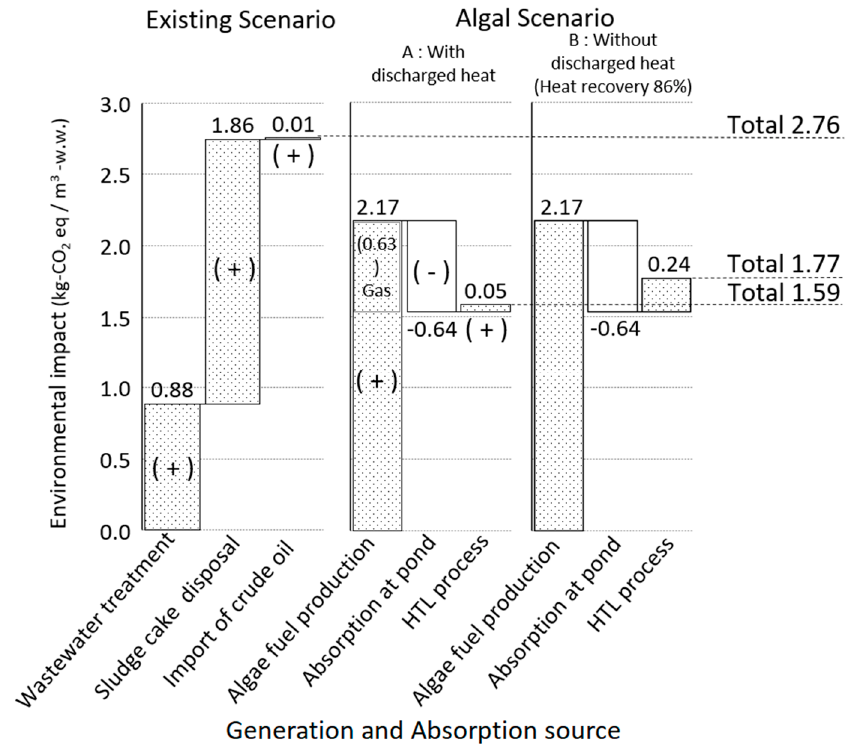
Figure 9. Environmental impact in terms of GWP100 for each operating cost scenario (Scenario B added from Reference [2]).